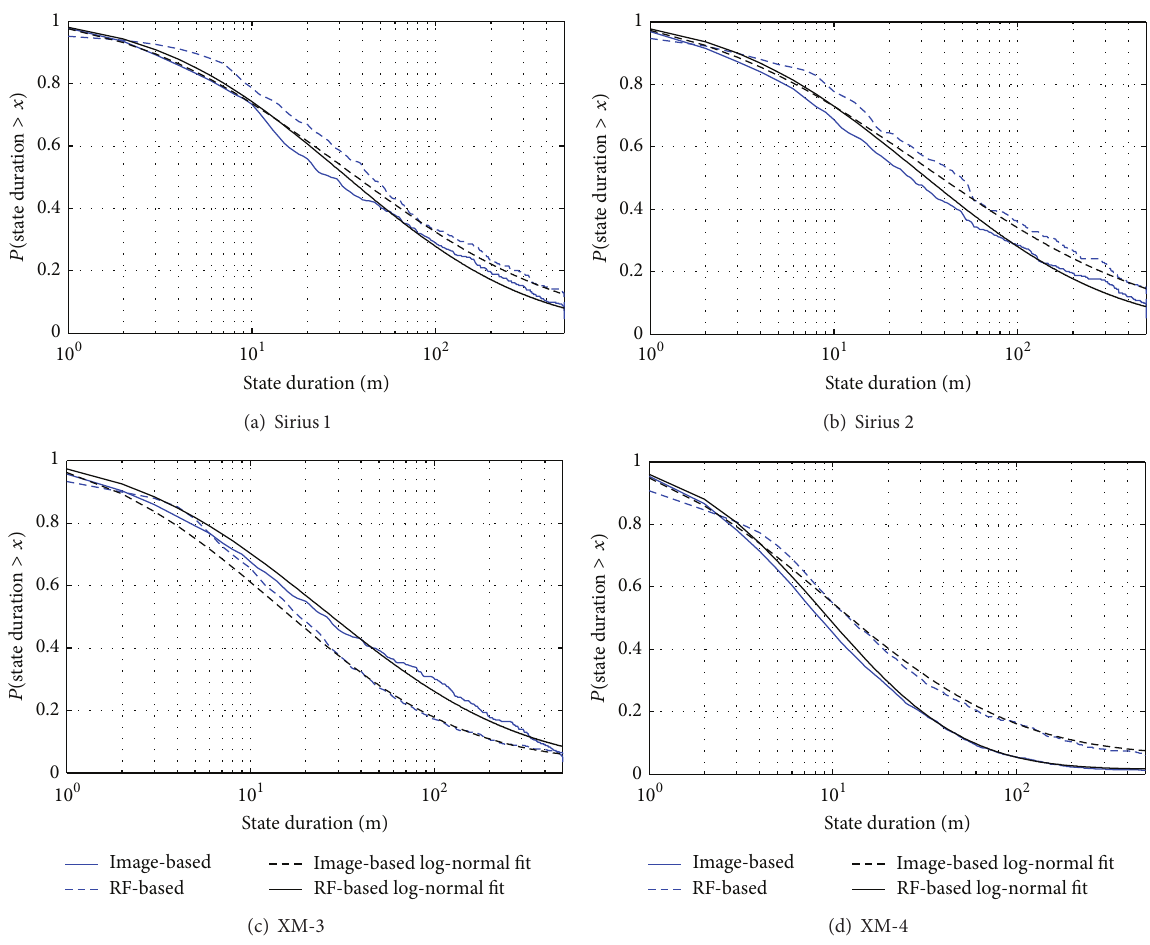
Figure 6: Statistics for good state for each satellite (Sirius 1, Sirius 2, XM-3, and XM-4) obtained from the image-based state estimation method (blue solid lines). As a ground truth, the same plots are shown for the states obtained from the RF measurements (blue dashed lines). Furthermore, the log-normal fitting is shown based on images and RF data, respectively (black curves).